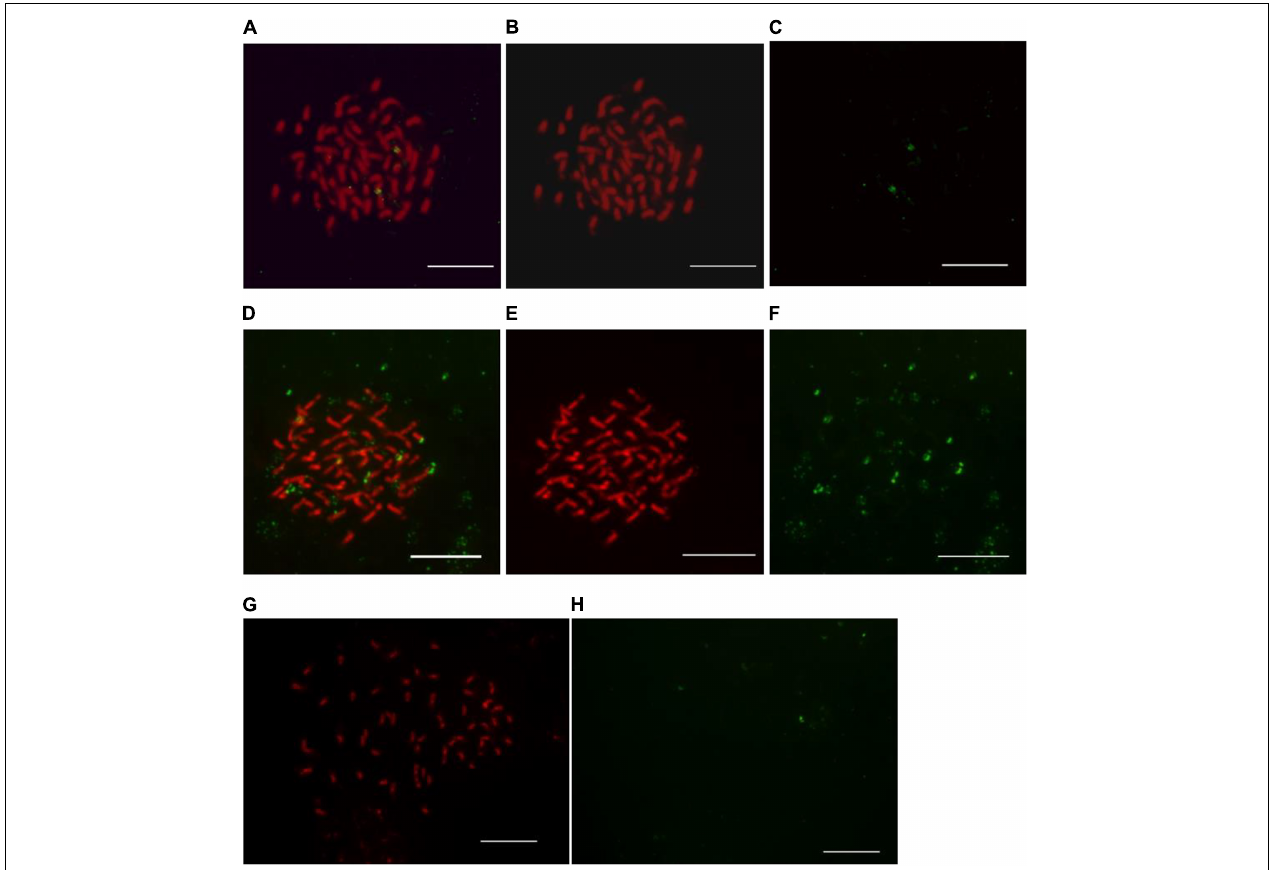
FIGURE 1 | Observation of post-hybridization washing temperature impact on 45S ribosomal DNA-fluorescence in situ hybridization in kiwifruit. The post-hybridization washing temperature of 37, 35, and 42 ◦ C were applied in panels (A–H) , respectively. Hybridization sites in panels (B,C) and (E,F) were digitally separated from the merged images of panel (A,D) , respectively. The white scale bar represents 5 µ m.